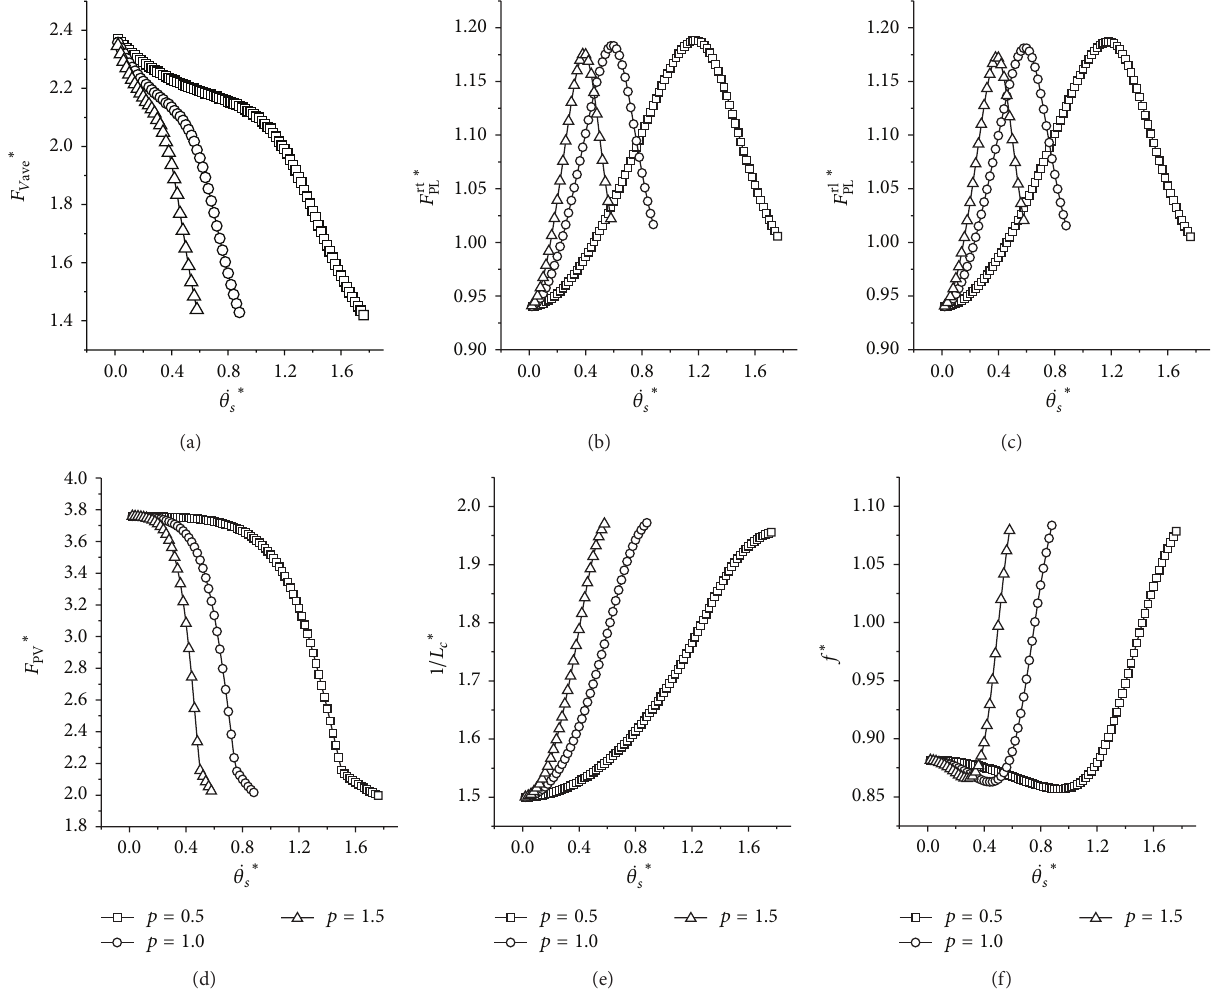
Figure 9: Influence of different body proportions on the bounding model. (a) The average vertical force; (b) and (c) are the peak leg force for the rear trailing and the leading legs, respectively; (d) the peak ground reaction force; (e) the result of the indicator of the metabolic cost of transport; (f) the locomotion frequency. Initial conditions: 𝑦 ∗ 𝑠 = 1 , 𝜇 = 0 , V ∗ = 1.4 , and 𝑘 𝑎 = 1.0 .